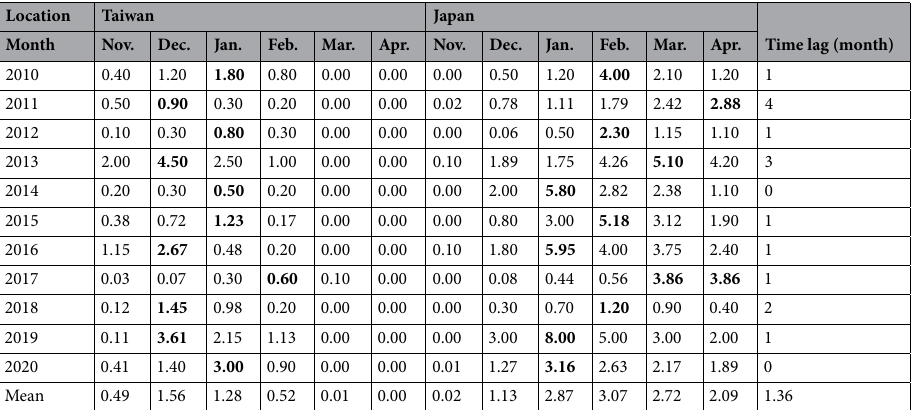
Table 1. The time series and the calculated time lag of catch data (percentage) during November to next April in Taiwan and Japan. The numbers in bold represent the month with the highest percentage during the period.